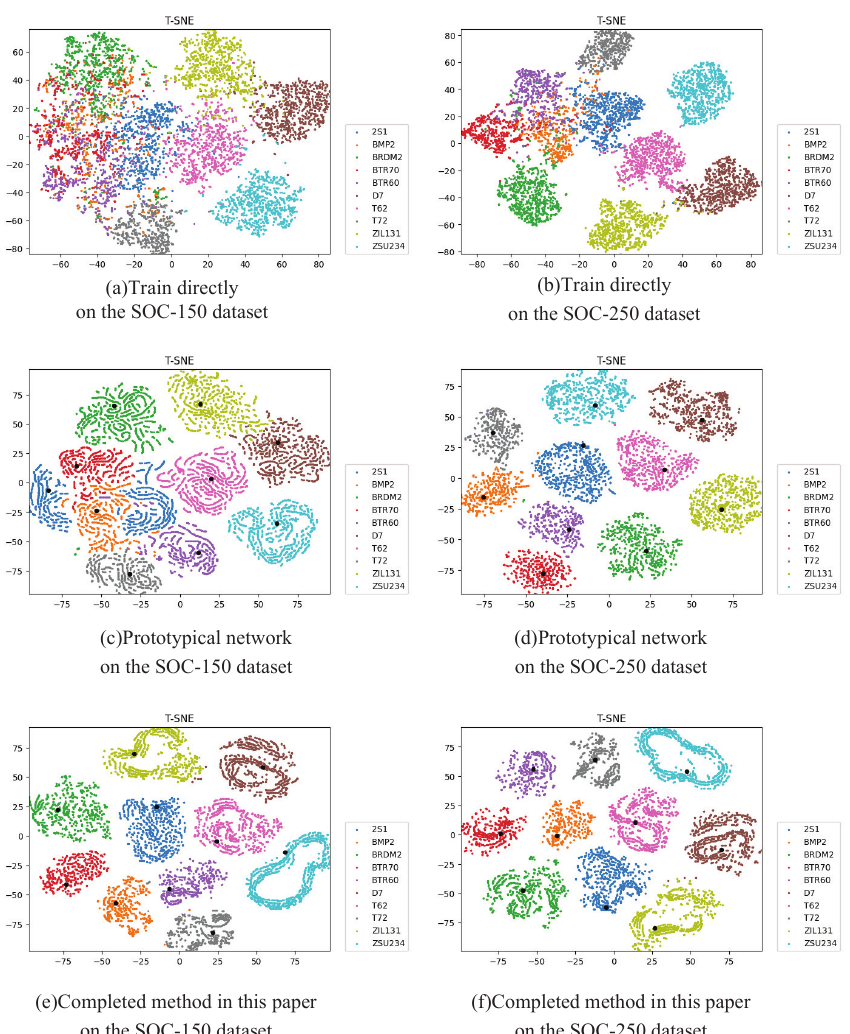
Figure 12. t-SNE visualization of testing dataset